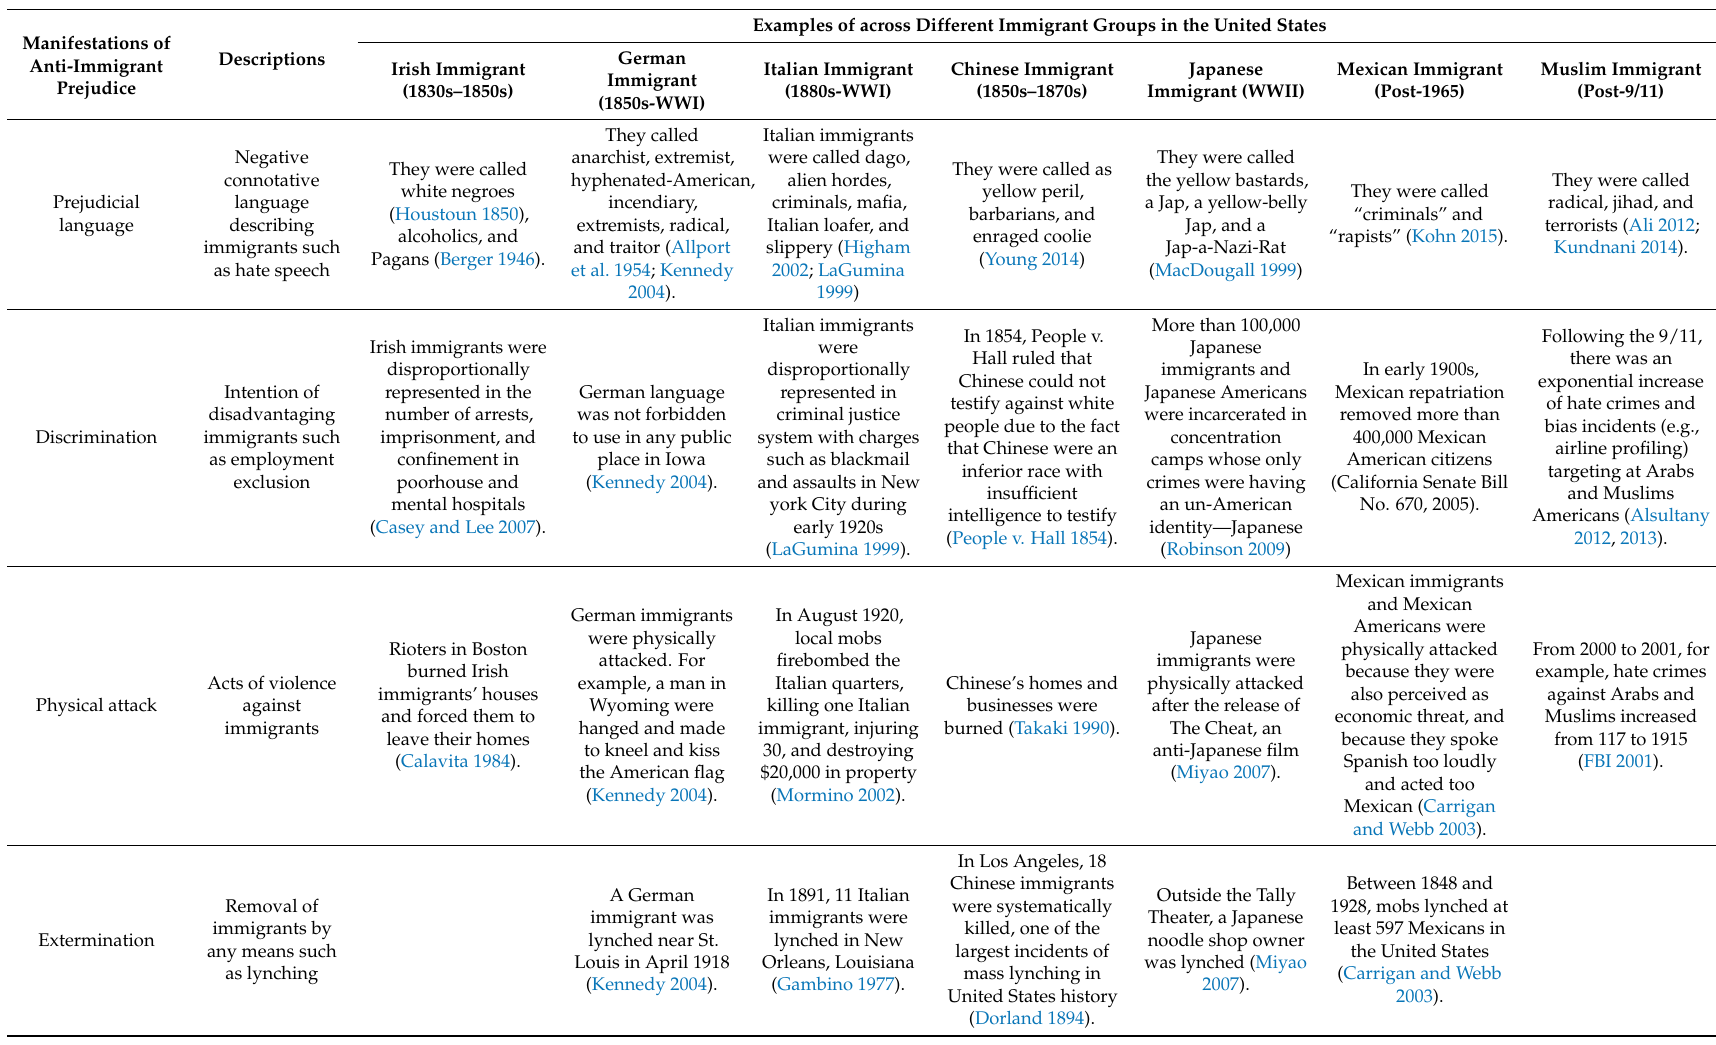
Table 1. Manifestations of anti-immigrant prejudice across different groups in the United